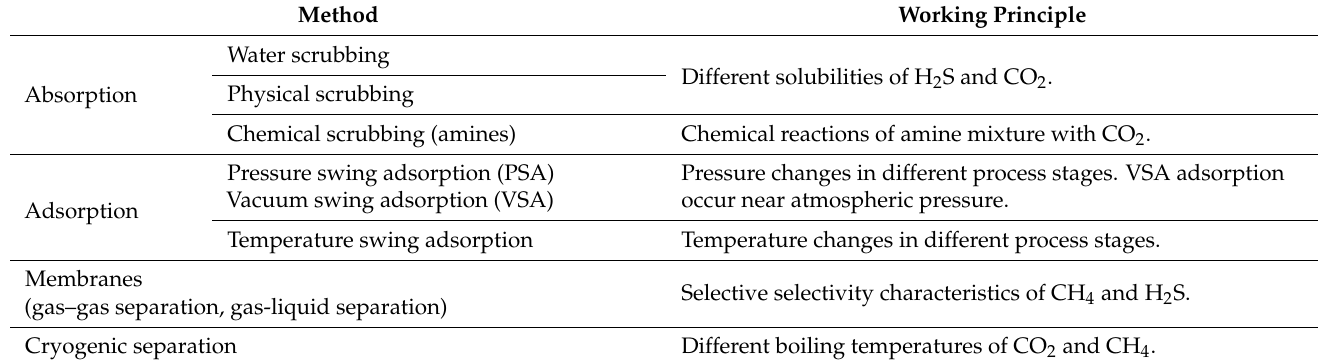
Table 5. Biogas upgrading